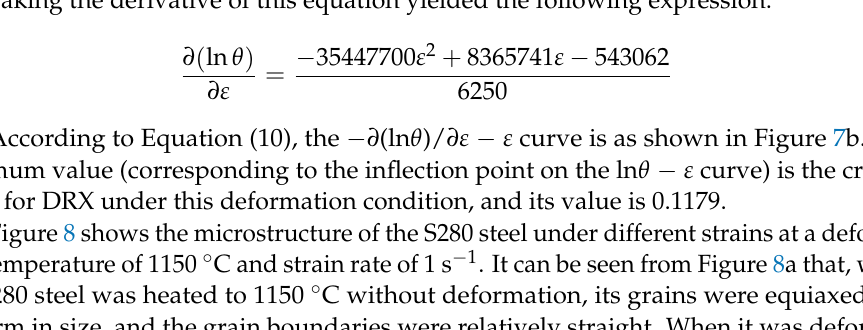
Figure 7. Relationship between ln𝜃– 𝜀 and − ∂(ln𝜃)/ ∂ − 𝜀 for S280 steel at a deformation tem- perature of 1150 °C and strain rate of 1 s − 1 : ( a ) ln𝜃 − 𝜀 ; ( b ) − ∂(ln𝜃)/ ∂𝜀 − 𝜀 . Figure 8 shows the microstructure of the S280 steel under different strains at a defor- mation temperature of 1150 °C and strain rate of 1 s − 1 . It can be seen from Figure 8a that,